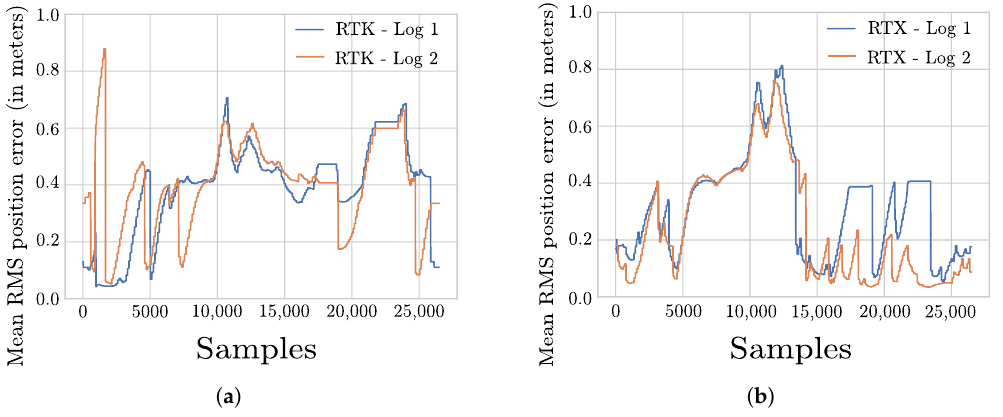
Figure 7. RMS values estimated by the Applanix POS LV-220 system during the course of laps around the University of Wuppertal. ( a ) Estimated RMS values during RTK position updates. ( b ) Estimated RMS values during RTX position updates.